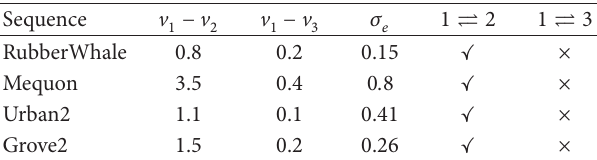
Table 1: Numerical results of real image experiments and separabil- ity predictions between different